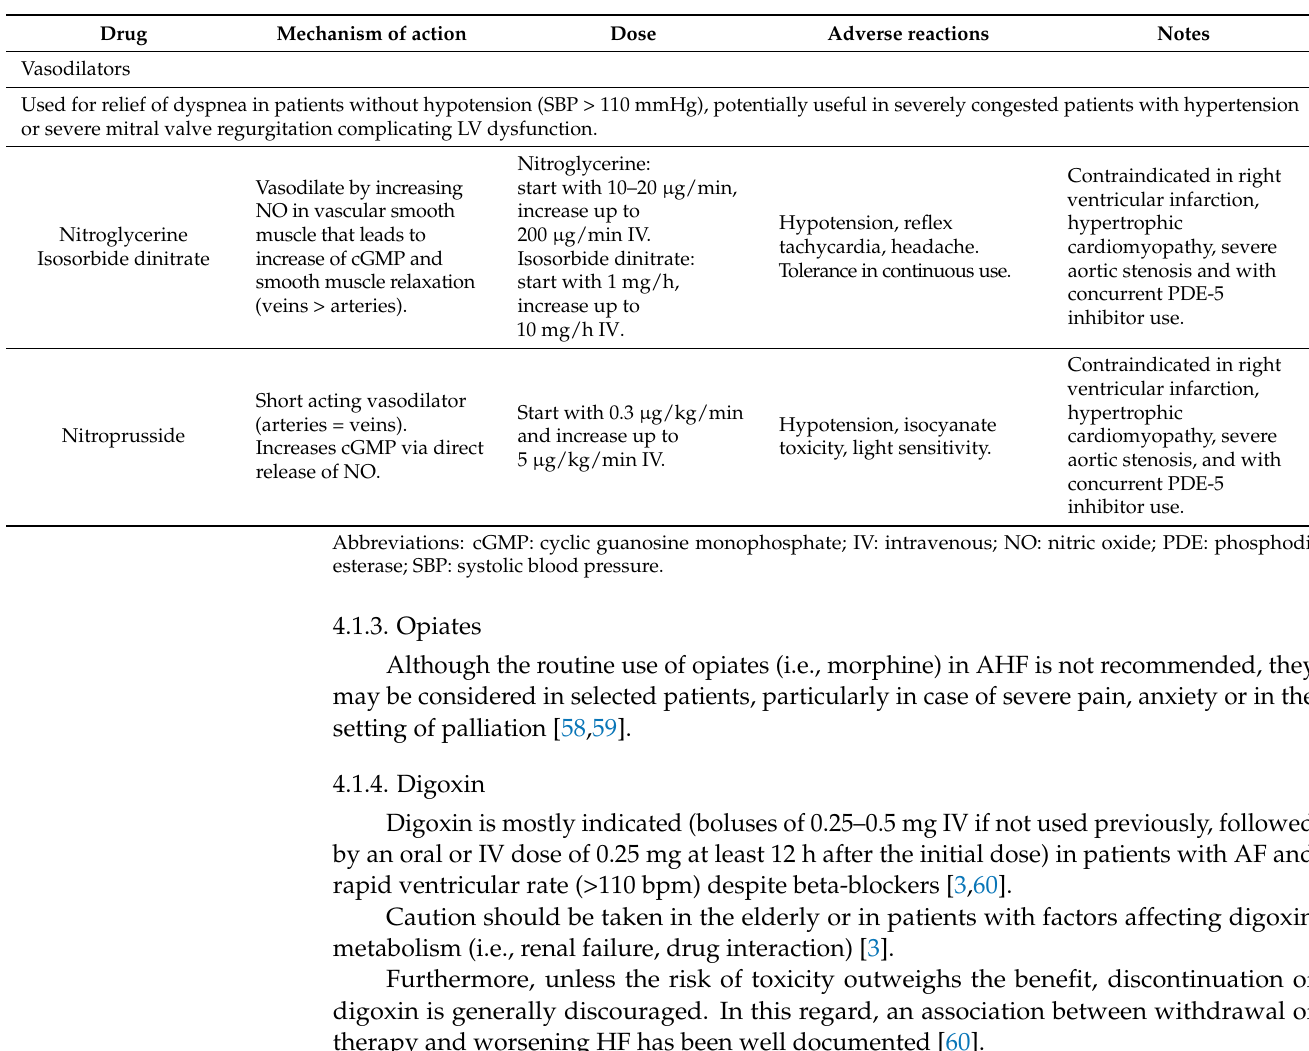
Table 6. Vasodilators